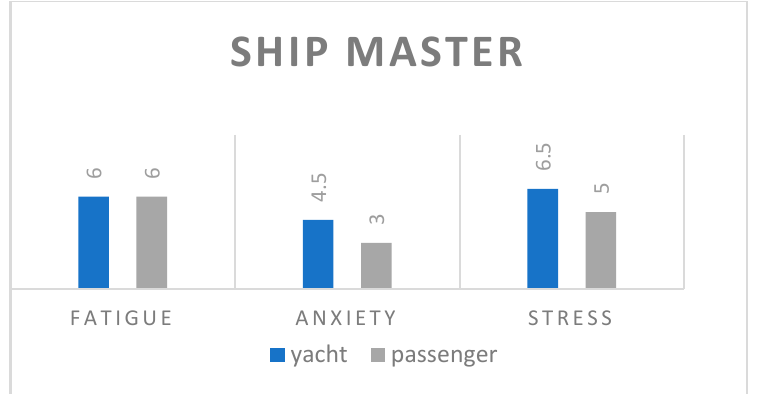
Figure 4. Comparison of the fatigue, anxiety and stress rates in yacht and passenger ship masters. The analysis of data obtained from the engine officers produced fatigue, anxiety and stress rates that are worse than in deck officers. Engine officers aged 26–55 serving on cargo and passenger ships show a very high level of stress and nervousness. Engineers aged 36–55 report considerably higher values of fatigue than their younger peers. The results of the survey analysis show a significant level of fatigue and stress in all engine officers, regardless of the type of vessel they serve. A strong presence of anxiety is also reported in all surveyed engineering officers (Figure 5).